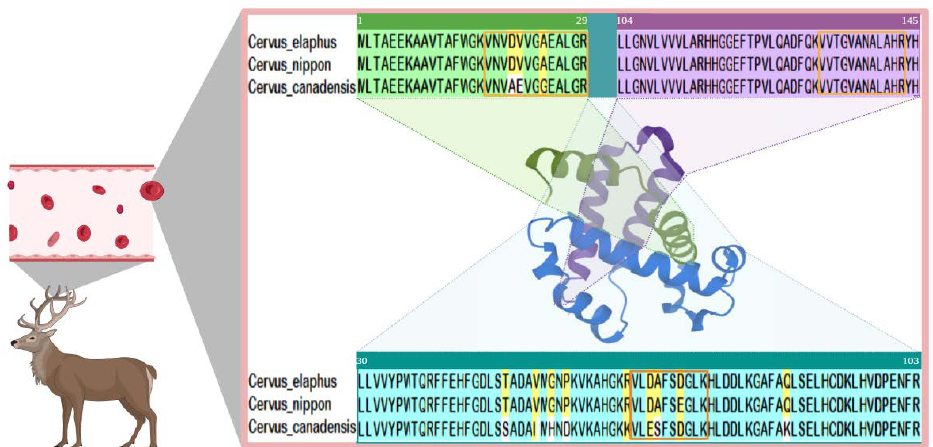
Figure 6. Sequence alignment of deer’s HBB A. (Adapted from “Blood Oxygenation”, by BioRen- der.com (accessed on 25 May 2022. Retrieved from https://app.biorender.com/biorender-templates (accessed on 25 May 2022). Structure of HBB A downloaded from AlphaFold Protein Structure Database [32,33], Hemoglobin subunit beta-A, Source organism: Bos javanicus , https://www. alphafold.ebi.ac.uk/entry/P04346 (accessed on 23 May 2022). The HBB A amino acid sequences were downloaded from UniPort (http://www.uniprot.org/ (accessed on 2 March 2022)). The green part represents amino acids 1–29, the blue part represents amino acids 30–103, and the purple part rep- resents amino acids 104–145. Yellow labels represent amino acids with a similarity greater than 50%.